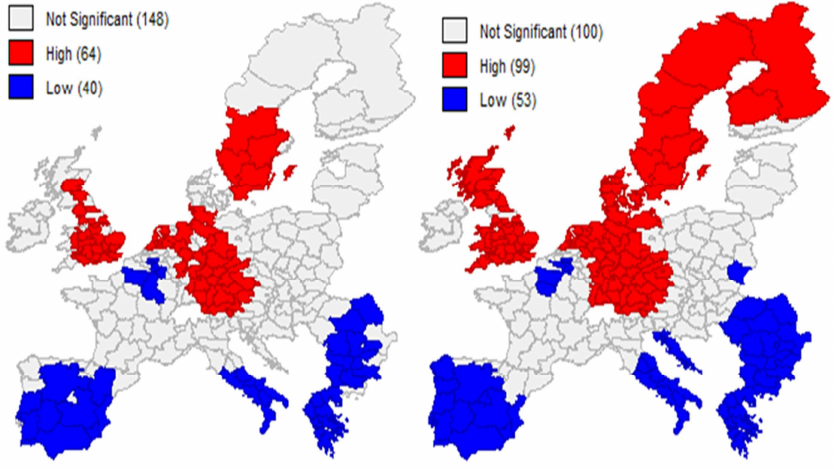
Figure 6. Local Getis-Ord cluster map of employment rate in 2016 — spatial weights: queen (left) and 8 — nearest neighbours